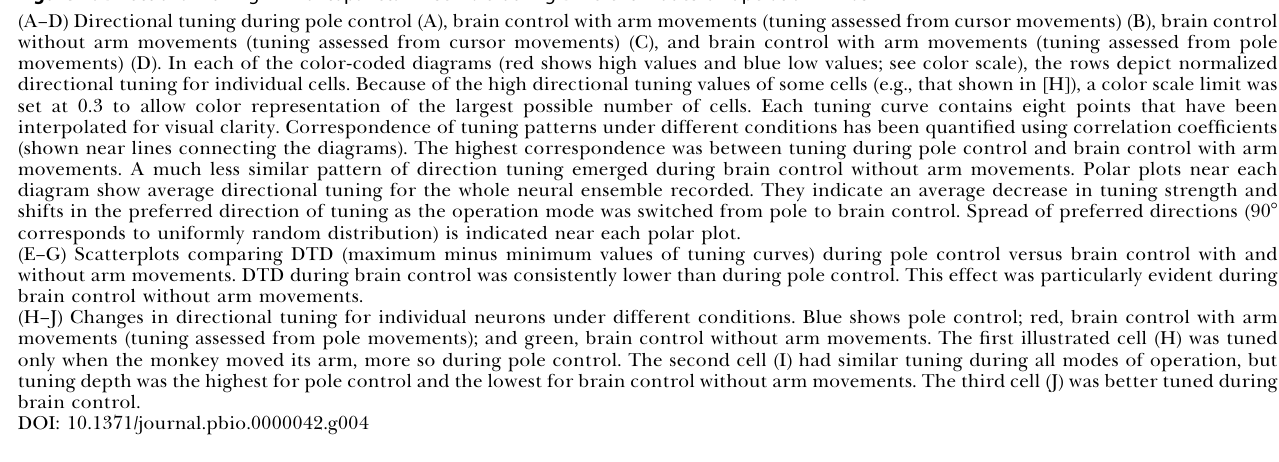
Figure 4. Directional Tuning in Frontoparietal Ensemble during Different Modes of Operation in Task 1 (A–D) Directional tuning during pole control (A), brain control with arm movements (tuning assessed from cursor movements) (B), brain control without arm movements (tuning assessed from cursor movements) (C), and brain control with arm movements (tuning assessed from pole movements) (D). In each of the color-coded diagrams (red shows high values and blue low values; see color scale), the rows depict normalized directional tuning for individual cells. Because of the high directional tuning values of some cells (e.g., that shown in [H]), a color scale limit was set at 0.3 to allow color representation of the largest possible number of cells. Each tuning curve contains eight points that have been interpolated for visual clarity. Correspondence of tuning patterns under different conditions has been quantified using correlation coefficients (shown near lines connecting the diagrams). The highest correspondence was between tuning during pole control and brain control with arm movements. A much less similar pattern of direction tuning emerged during brain control without arm movements. Polar plots near each diagram show average directional tuning for the whole neural ensemble recorded. They indicate an average decrease in tuning strength and shifts in the preferred direction of tuning as the operation mode was switched from pole to brain control. Spread of preferred directions (90 8 corresponds to uniformly random distribution) is indicated near each polar plot. (E–G) Scatterplots comparing DTD (maximum minus minimum values of tuning curves) during pole control versus brain control with and without arm movements. DTD during brain control was consistently lower than during pole control. This effect was particularly evident during brain control without arm movements. (H–J) Changes in directional tuning for individual neurons under different conditions. Blue shows pole control; red, brain control with arm movements (tuning assessed from pole movements); and green, brain control without arm movements. The first illustrated cell (H) was tuned only when the monkey moved its arm, more so during pole control. The second cell (I) had similar tuning during all modes of operation, but tuning depth was the highest for pole control and the lowest for brain control without arm movements. The third cell (J) was better tuned during brain control. DOI: